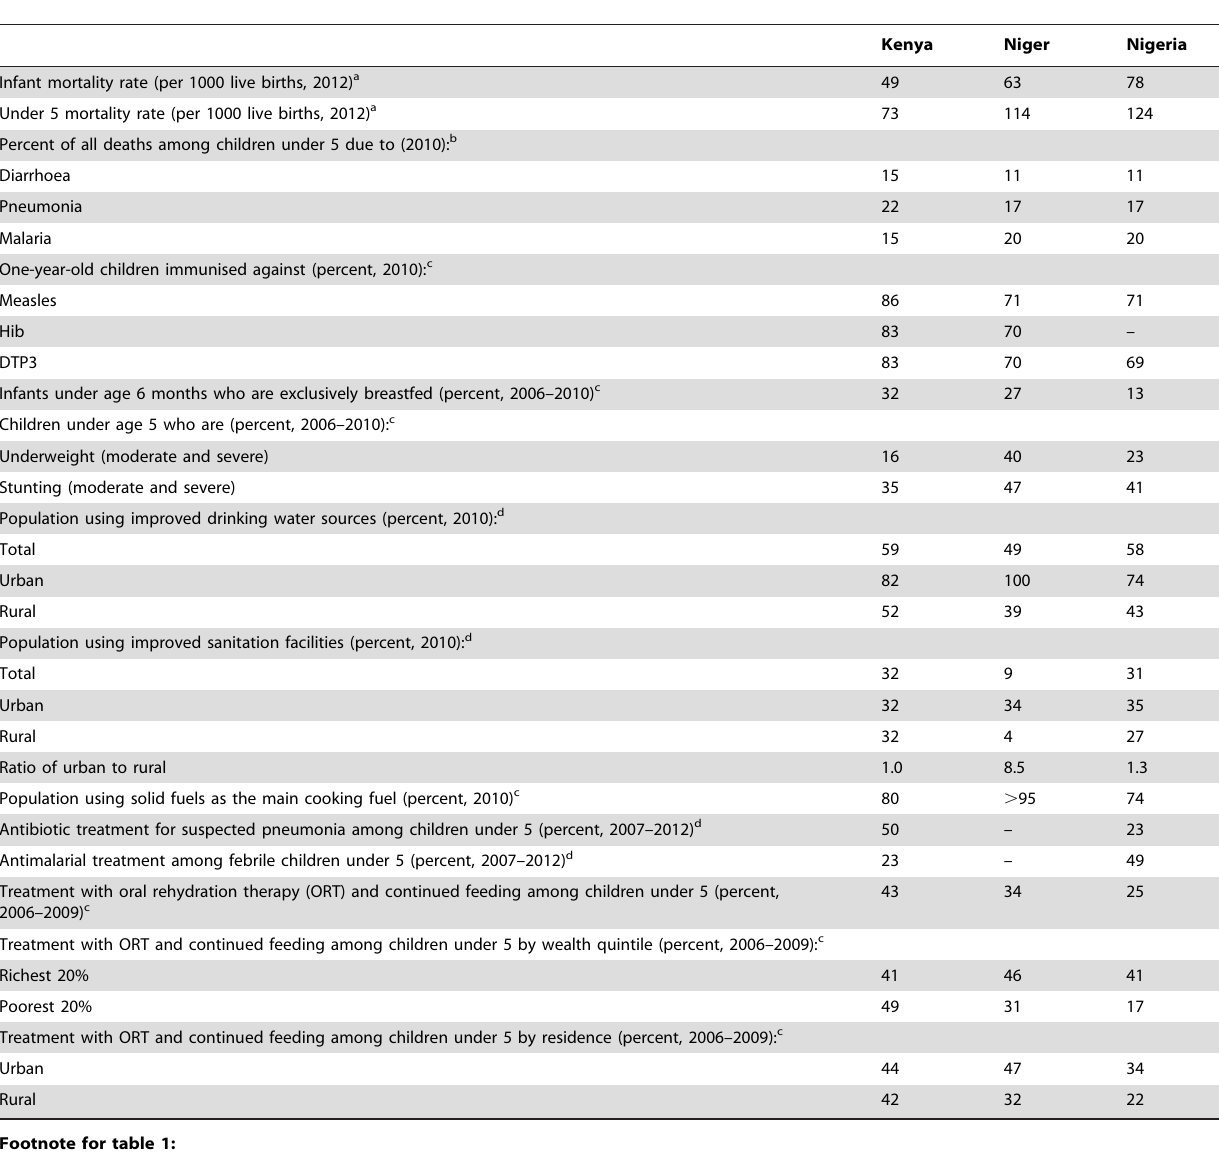
Table 1. The burden of diarrhoea, pneumonia and malaria and related indicators, Kenya, Niger and Nigeria (various years).